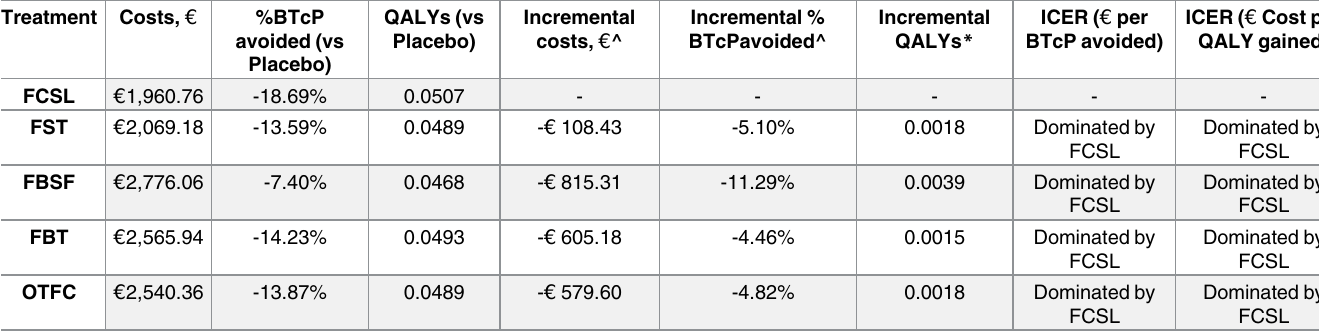
Table 4. Base-case analysis